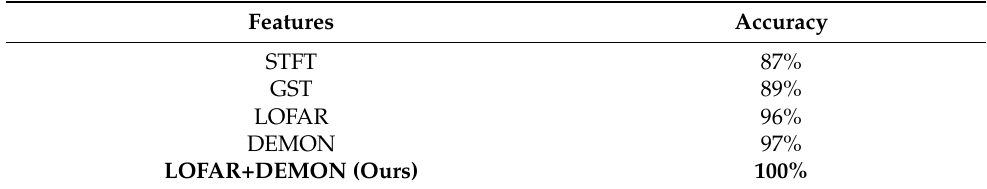
Table 8. Performance of the algorithm based on different features on the lake trial dataset in object counting task (COMB excluded).